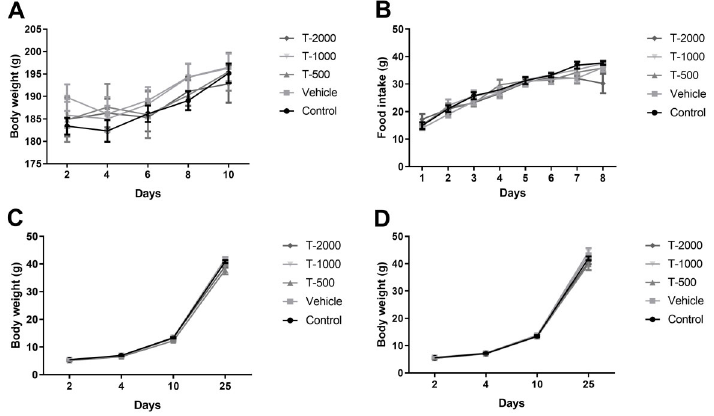
Figure 1. Effect of valerian treatment on body weight and food intake of mothers and on body weight of the offspring. Groups: Control (1 mL distilled water), vehicle (1 mL distilled water, 20% of glycerol), T-500 (500 mg (cid:1) kg – 1 (cid:1) day – 1 of valerian), T-1000 (1000 mg (cid:1) kg – 1 (cid:1) day – 1 of valerian), and T-2000 (2000 mg (cid:1) kg – 1 (cid:1) day – 1 of valerian). A , Body weight of mothers (F(4, 347)=1.036, P=0.3885). B , Food intake of mothers (F(4, 347)=8.034, P=0.3885). C , Body weight of female offspring on postnatal days 2, 4, 10, and 25 (F(4, 262)=6.646, P=0.092). D , Body weight of male offspring on postnatal days 2, 4, 10, and 25 (F(4, 254)=4.748, P=0.1010). Data are reported as means ± SE of